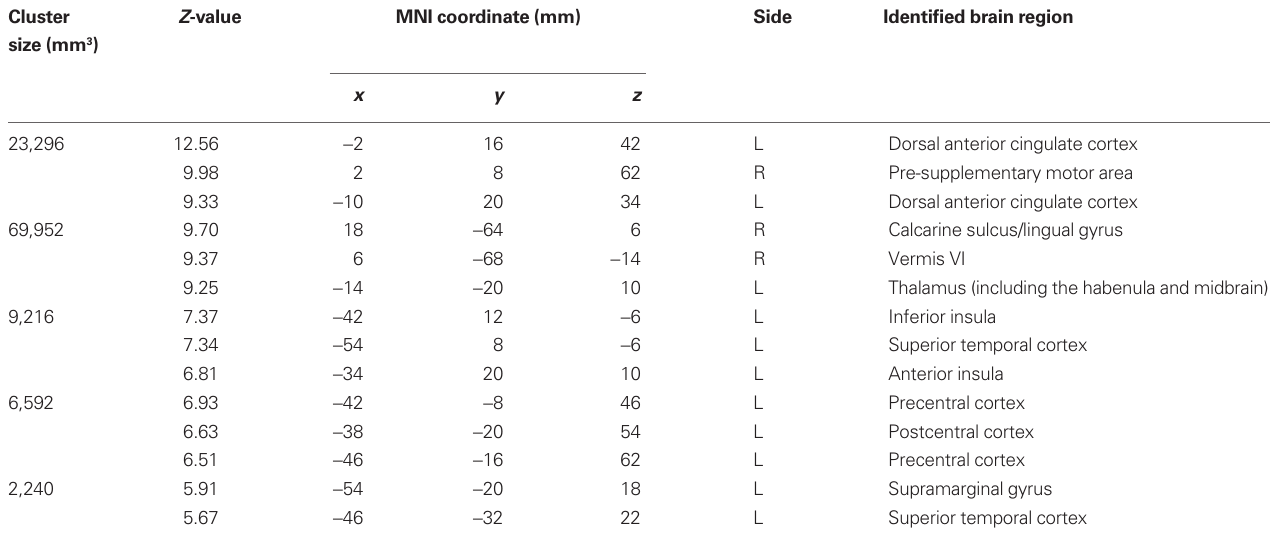
Table 1 | Brain regions showing greater activation during stop error (Se), compared to stop success (SS), trials in the stop signal task ( p < 0.05, corrected for